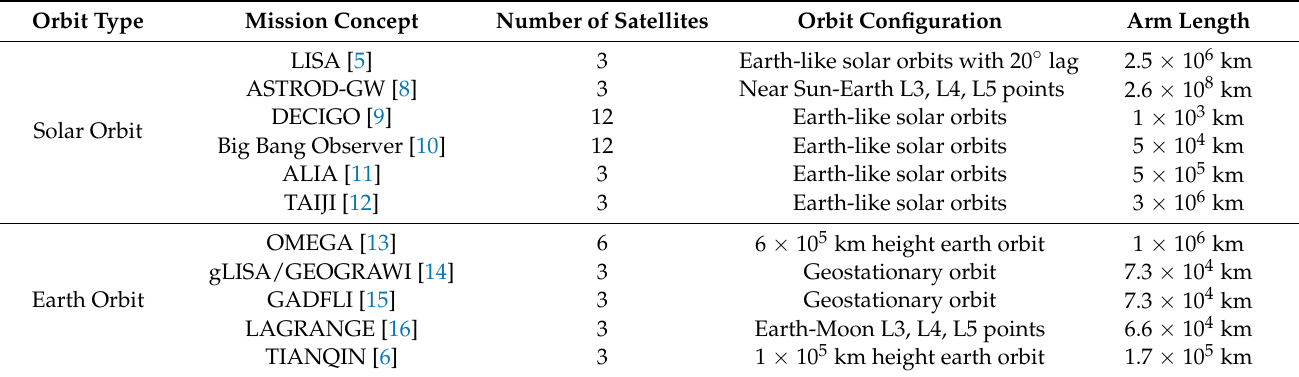
Table 1. Table 1. Main space GW detection programs all over the Table 1. Main space GW detection programs all over the world.